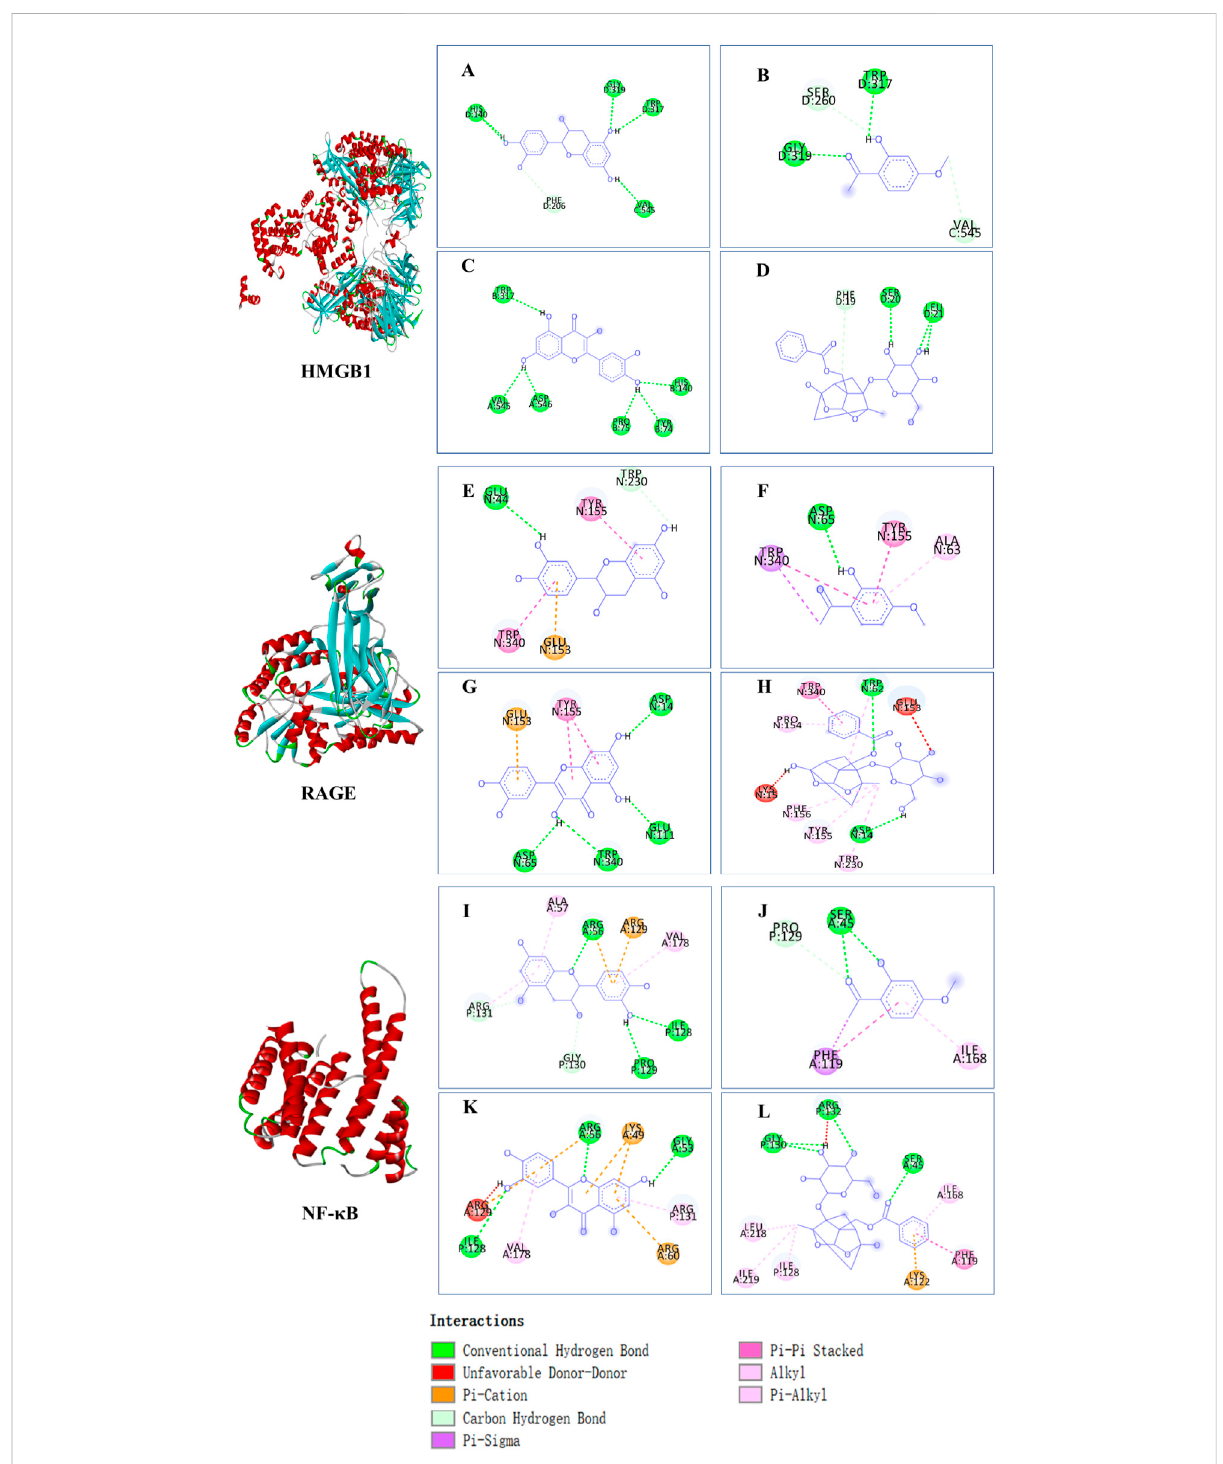
FIGURE 2 Molecular docking analysis of the putative binding. Binding modes between catechin, paeonol, quercetin, paeoni fl orin, and HMGB1 ( A – D ), RAGE ( E – H ), and NF- κ B ( I – L ), respectively. HIS, histidine; GLY, glycine; TRP, tryptophan; PHE, phenylalanine; VAL, valine; SER, serine; ASP, aspartic acid; PRO, proline; TYR, threonine; LEU, leucine; GLU, glutamic acid; ALA, alanine; LYS, lysine; ARG, arginine; ILE,